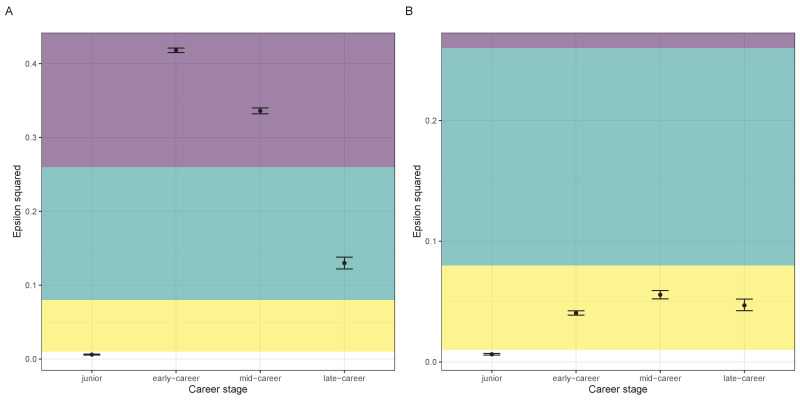
Effect size for the differences between archetypes within each career stage for A number of publications and B share of highly cited papers.Colored areas provide descriptive interpretation. Yellow indicates a small effect size, green indicates medium and purple indicates a large effect size. size.